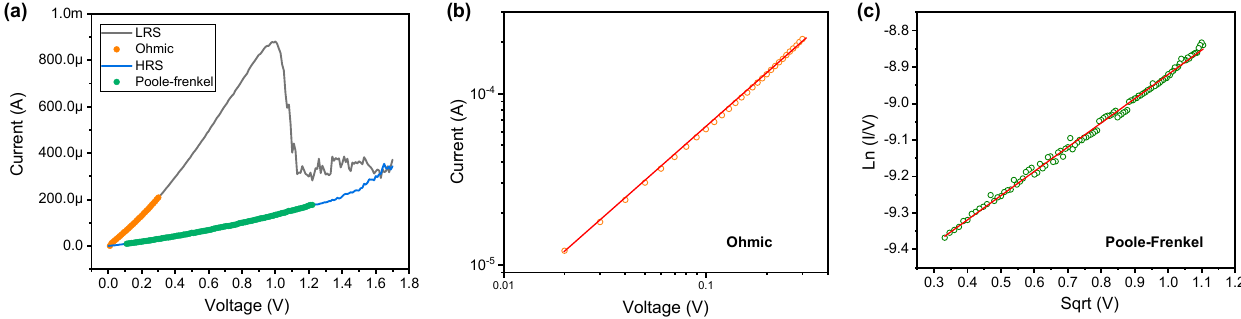
Figure 3. ( a ) Fitting process of the I–V curve in the linear scale for the conduction mechanism. ( b ) Log–log scale in the LRS. ( c ) Ln (I/V) versus sqrt (V) in the HRS.